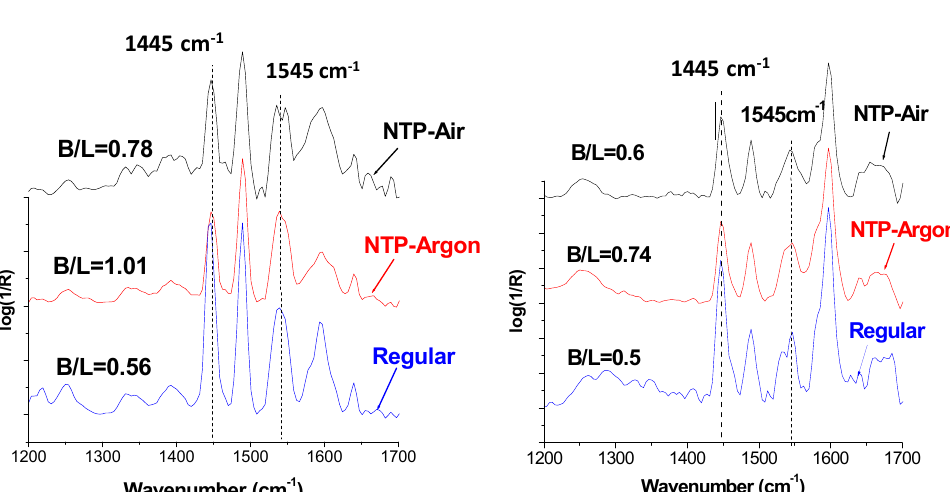
Figure 4. Py-FTIR spectra of NTP treated ( A ) HSiW-Al; ( B ) HSiW-Si in contrast to regularly fabricated counterparts (B/L: ratio of Brønsted acid sites to Lewis acid sites).